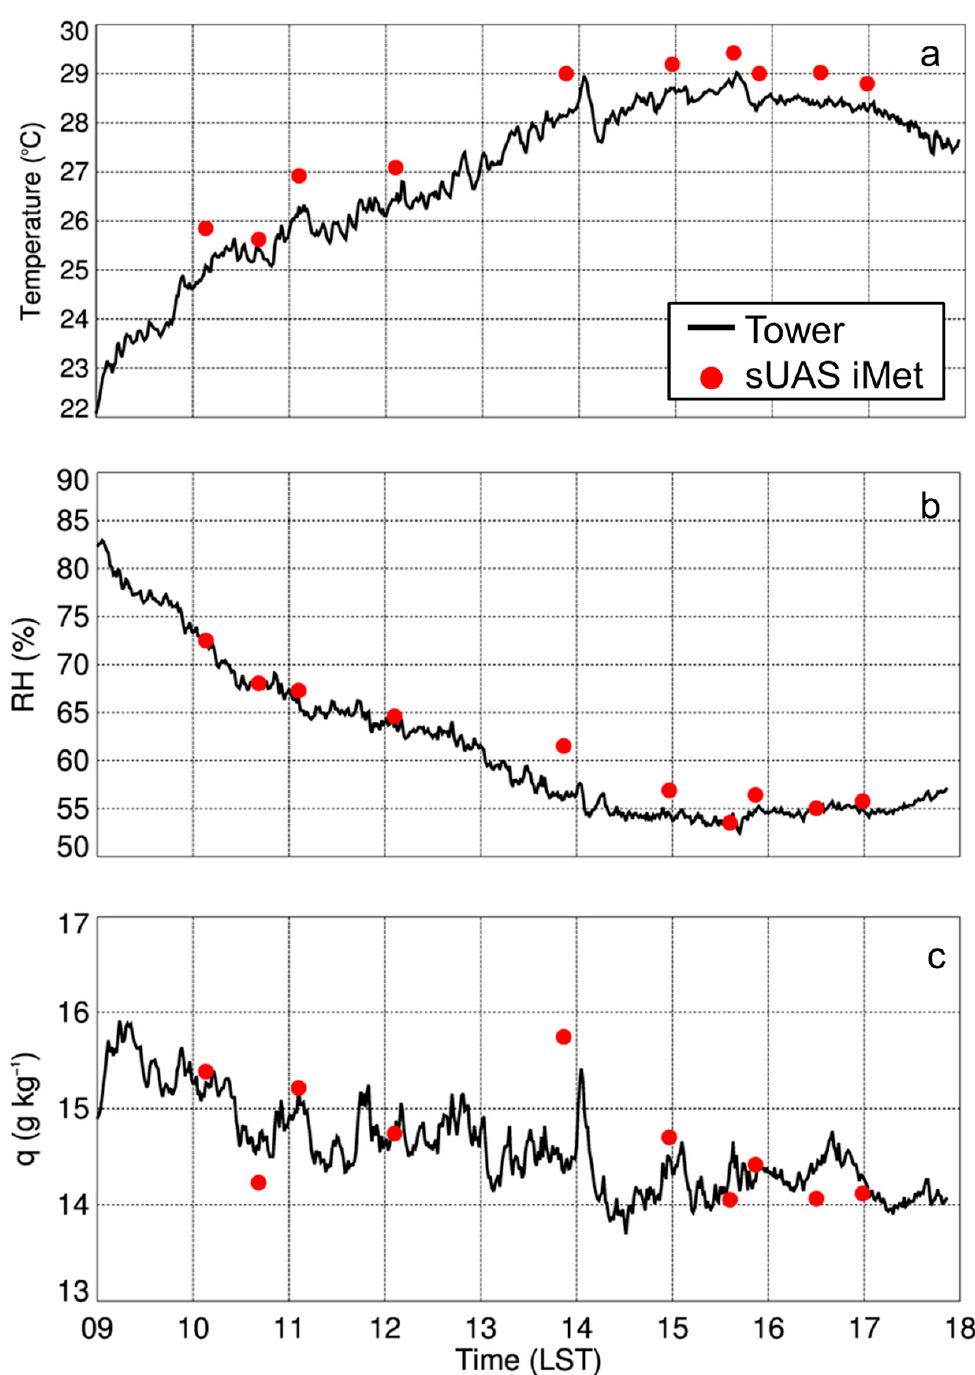
Figure 3. Temperature ( a ), relative humidity ( b ), and specific humidity ( c ) from the iMet-XQ sensors on the sUAS flown 28 April 2017 as a function of in situ measurements from the tower (black line) installed at Cullman, AL. sUAS measurements made represent the means of the lowest 5 m of the profile (red dots). Tower measurements were made at 2-m AGL and represent the 1-min means of 1-Hz samples. Table 4. Summary statistics on the inter-comparisons shown in the present study between the iMet-XQ sensors’ measurements of temperature (T), relative humidity (RH), and specific humidity (q) and measurements from: (1) A 10-m micrometeorological tower, (2) rawinsondes, (3) iMet-XQ sensors on the same sUAS platform, and (4) iMet-XQ sensors on different sUAS platforms. In the table below the, mean difference, standard deviation in the difference, root mean square error, R 2 , p -value, and number of cases are reported. When comparing the iMet-XQ measurements with the tower measurements, the means of the data ±15 min from the time of the sUAS flight were used for computing the statistics reported below. For all other comparisons, the means were computed in 10-m height bins and used to calculate the statistics reported below . Comparison